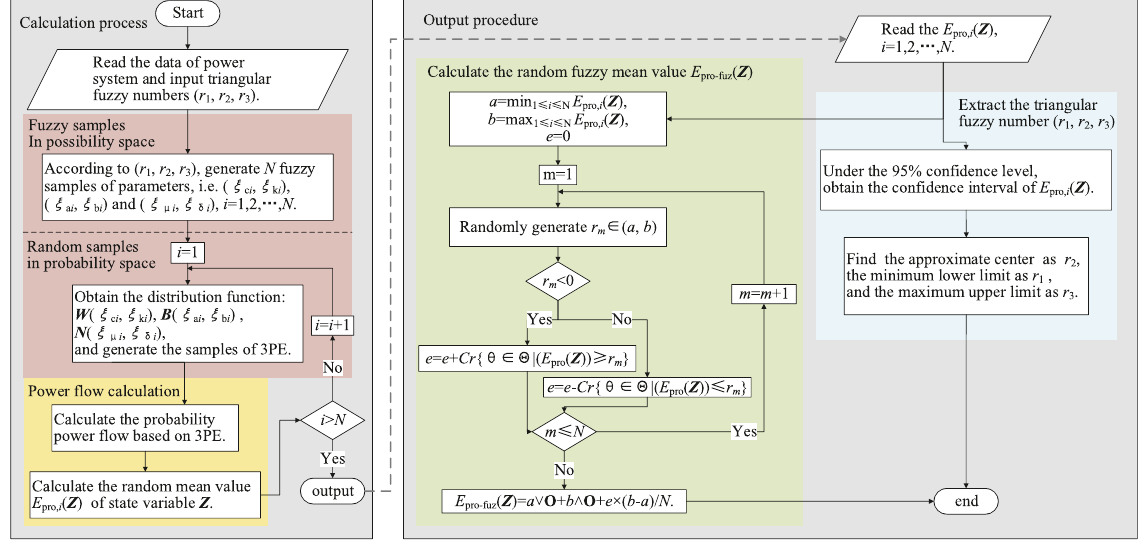
Figure 1: Flowchart of the calculation process of